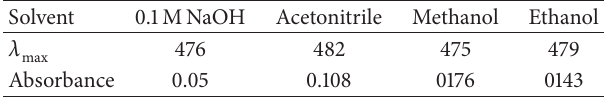
Table 1: Effect of the solvent system on the absorbance value of Cu(II)-MNDTT complex (20 𝜇 g Cu(II)/mL).